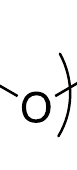
Figure 9. Structure of poly(lactic acid) (PLA).